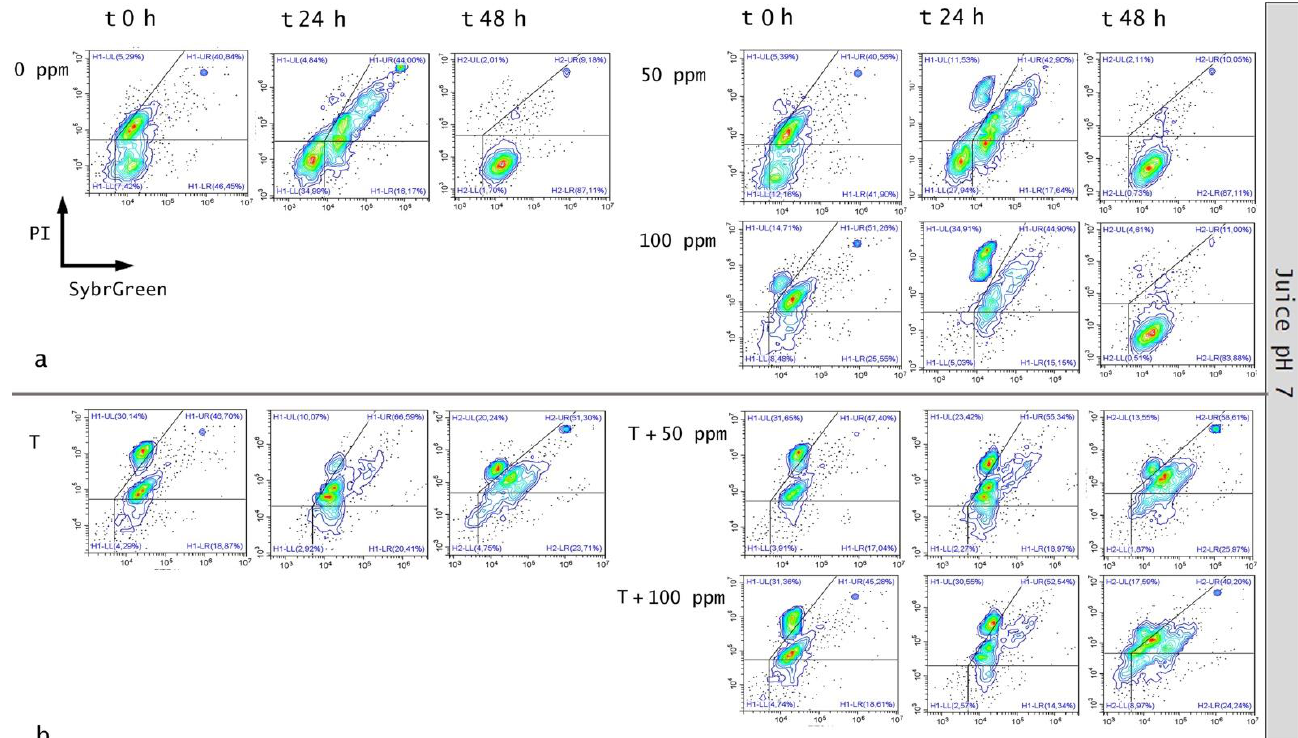
Figure 11. Double-staining density dot plot of E. coli cells in fruit juice (pH 7) diluted in PBS (pH 7.4): ( a ) 50 ppm and 100 ppm essential oil treatment and ( b ) combined thermal treatment at 65 °C with or without aroma compounds at 0, 24 and 48 h of incubation. Cells were stained with SYBR-Green I and PI simultaneously. H1-LL: unstained debris; H1-LR: intact cells/viable cells; H1-UR: injured cell population; H1-UL: permeabilized/dead cells. In the upper right side of the plot, a defined single population represents standard beads.